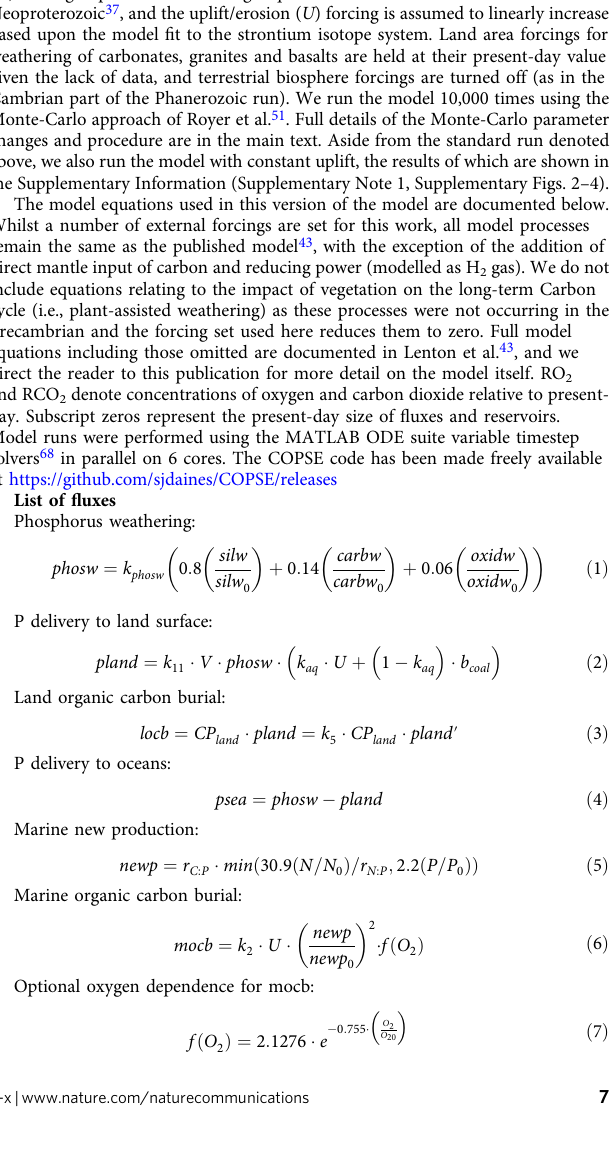
clades transitions from lower to higher oxygen requirement (and